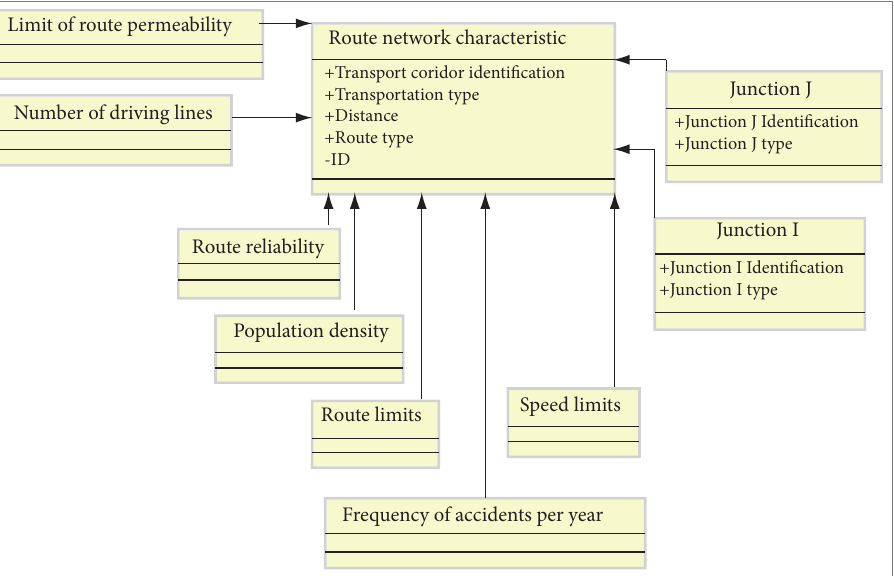
Fig. 2. The example of conceptual representation of main parameters of route stretch of the transportation network in the repository of data